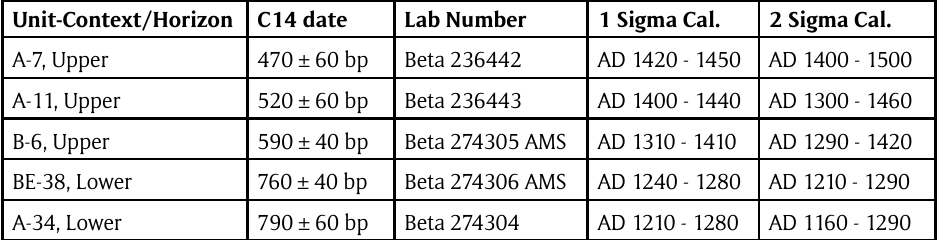
Table 1: Radiocarbon dates from the 2006 and 2009/10 excavations at Sorotomo; all dates are on wood charcoal.